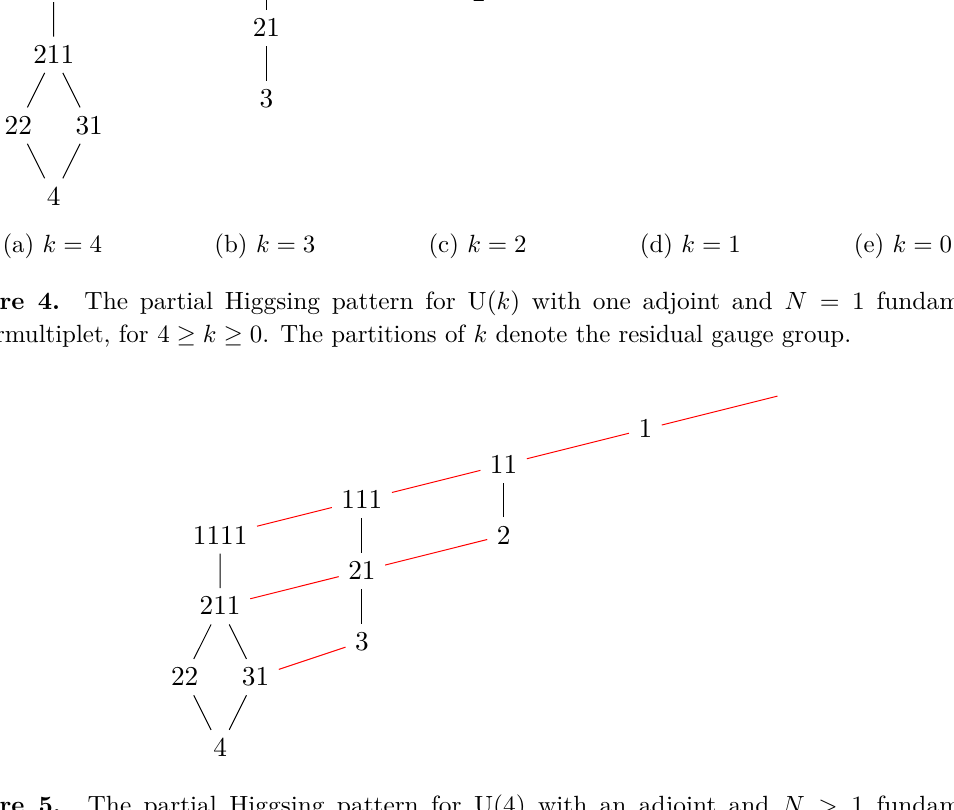
Figure 5. The partial Higgsing pattern for U(4) with an adjoint and N > 1 fundamental hypermultiplets. The partitions of 0 ≤ k 0 ≤ k = 4 denote the residual gauge group. The black transitions correspond to adjoint Higgsings (3.3) leaving the rank intact, the red transitions correspond to fundamental Higgsings (3.1) of U(1)